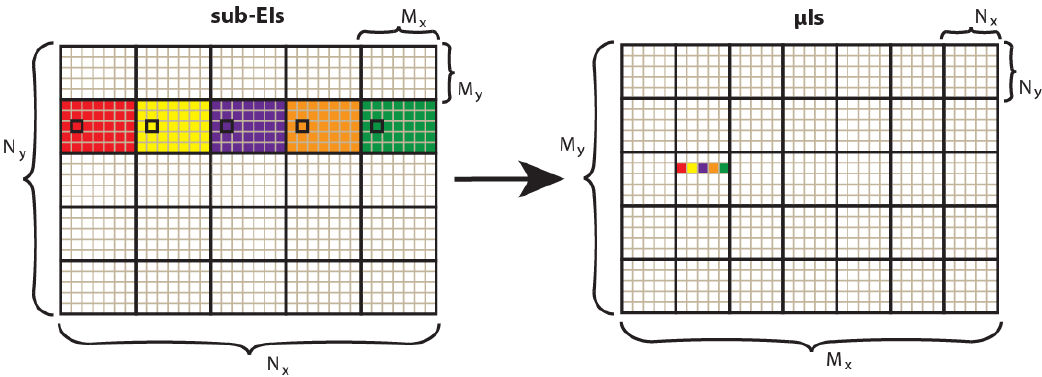
Figure 3. Transposition from sub-EIs to microimages. Starting from ( N x × N y ) sub-EIs, each one with ( M x × M y ) pixels, we obtain ( M x × M y ) microimages each one with ( N x × N y ) pixels. The correspondence is: p i,j ( µ I k,l ) = p k,l (sub-EI i,j ) , where p means